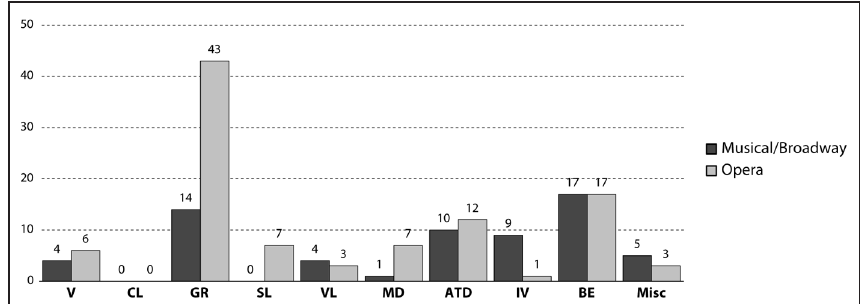
Figure 9: Number of opera vs. Broadway/musicals